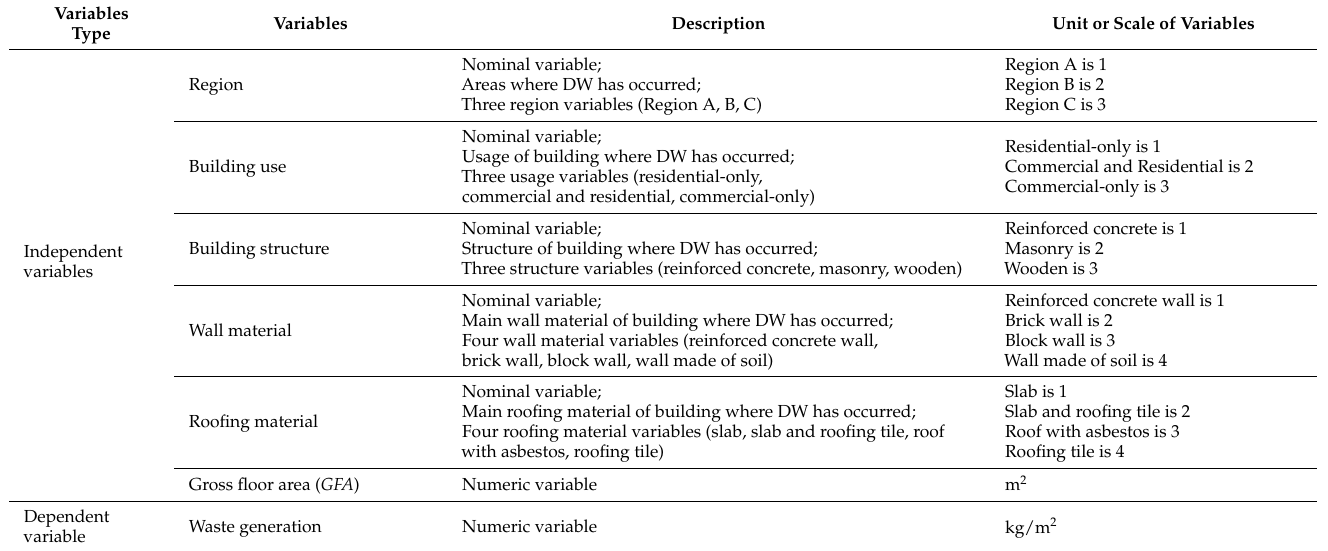
Table 2. Input and output variables used to develop the models in this